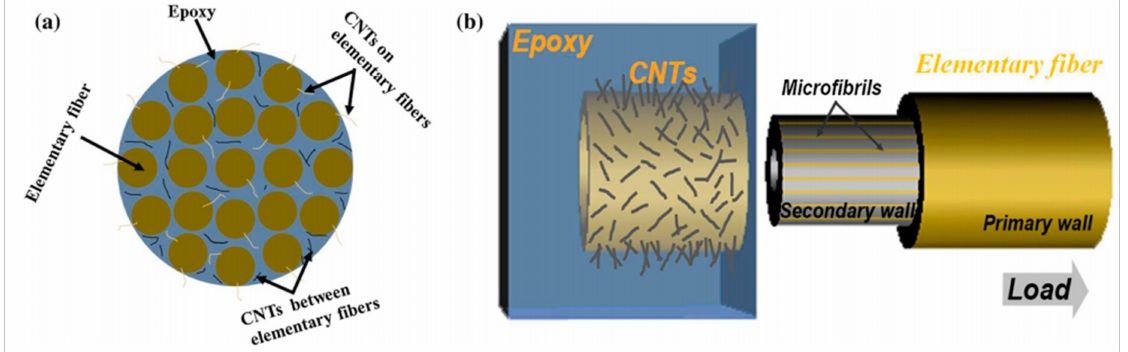
Figure 10. ( a ) Distribution of CNTs in flax yarn reinforced epoxy composites and ( b ) interlocking mechanism and failure process of composites (reprinted with permission from Li et al., 2015